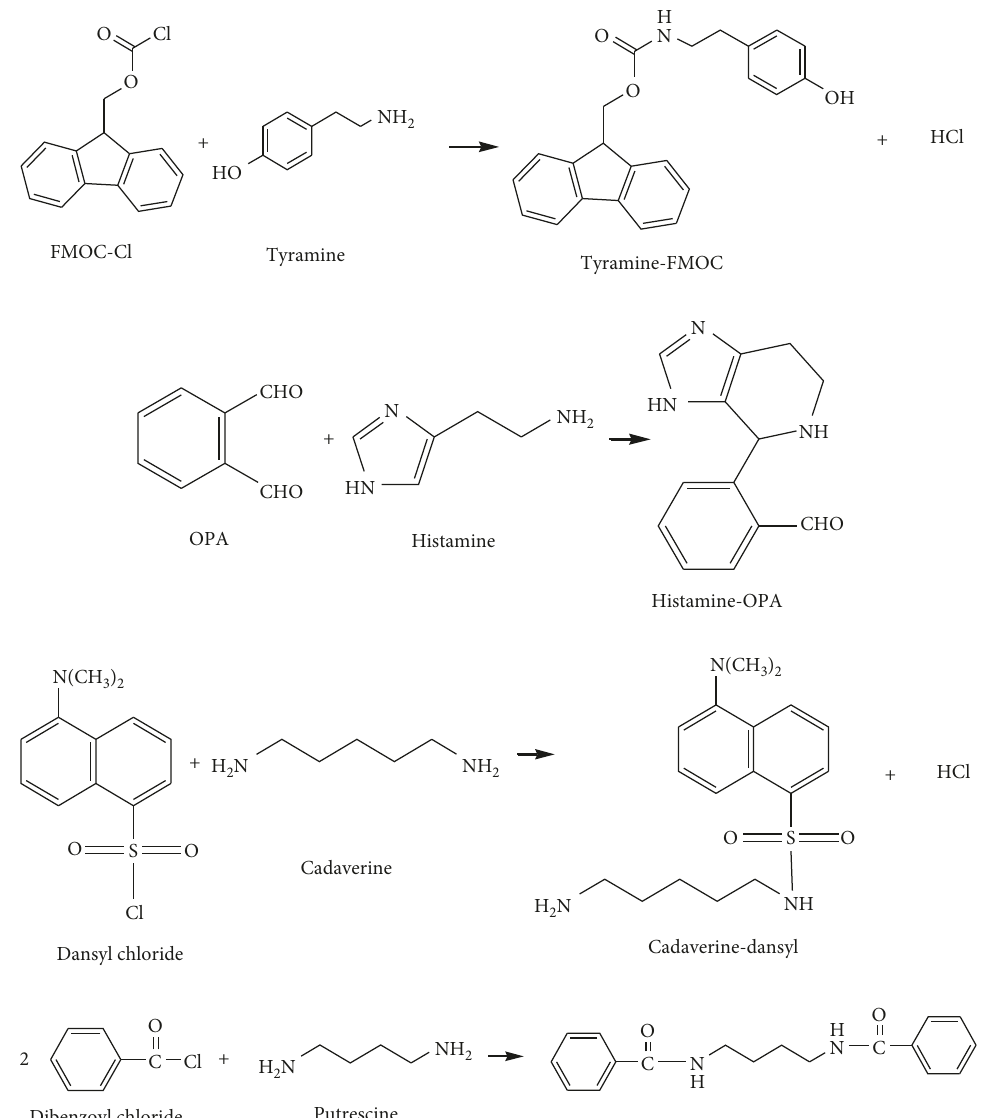
Figure 2: Reaction of derivative reagents such as FMOC-Cl with tyramine, OPA with histamine, dansyl chloride with cadaverine, and dibenzoyl chloride with putrescine, adopted from Lazaro and Conte-Junior